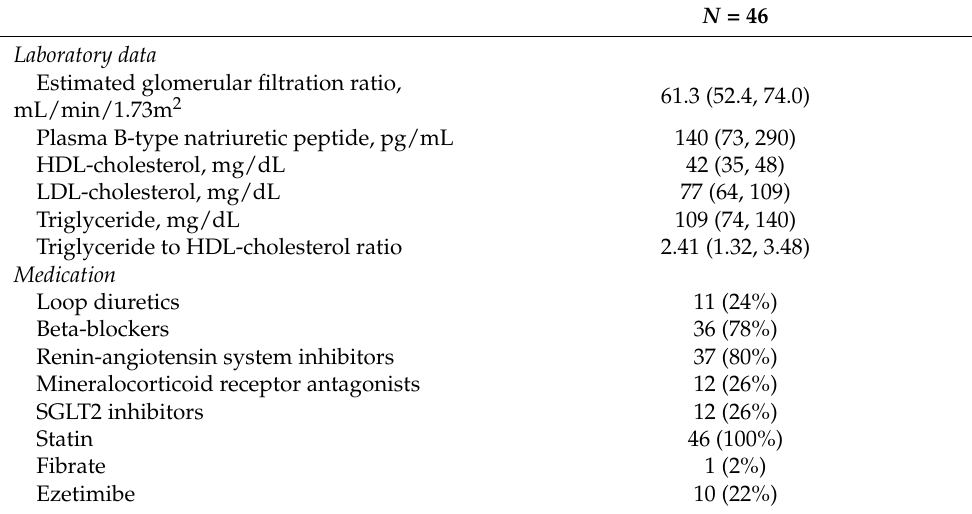
Table 3. Clinical characteristics at the index discharge.